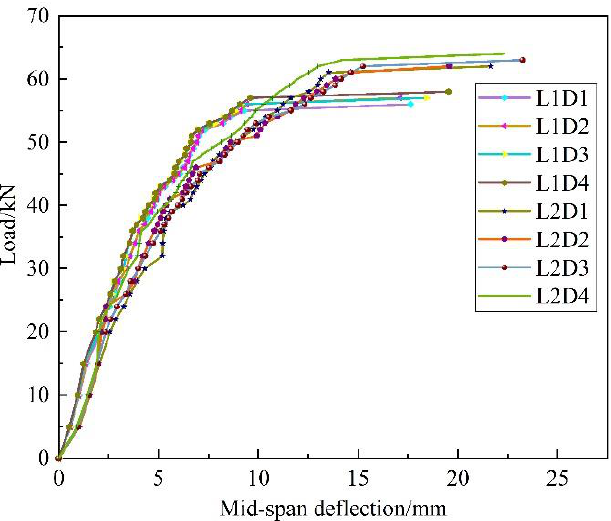
Figure 11. Load midspan deflection curve of ceramsite concrete beam in static load test.